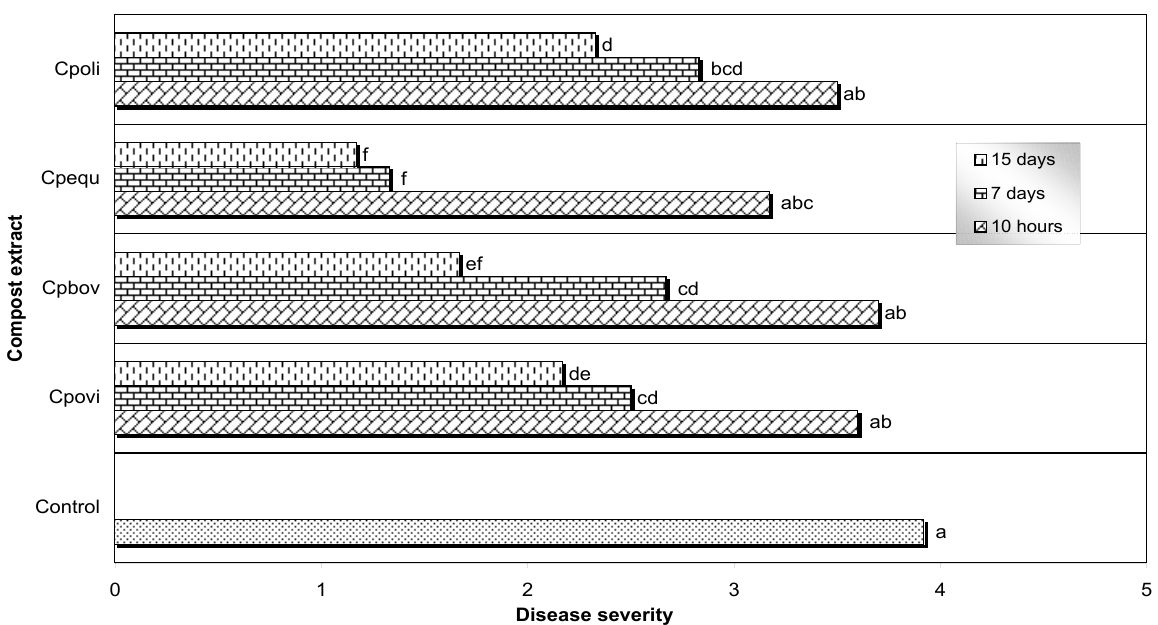
Fig. 2. Control of tomato grey mould by Trichoderma harzianum (TH20), Gliocladium (G1), and compost extracts (15 days of fermentation). Controls were sprayed with tap water before inoculation with Botrytis cinerea . For dis- ease scale and statistical analysis of data see caption in Fig. 1.